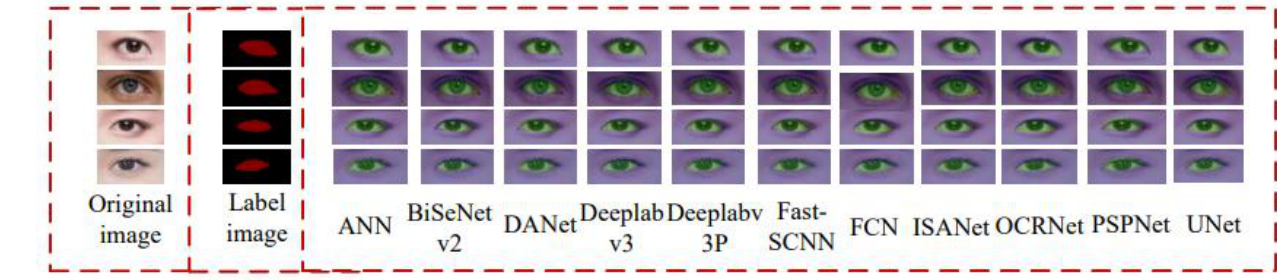
Figure 17. S egmentation result of 11 models on the left and right eye data. Figure 17. Segmentation result of 11 models on the left and right eye data.